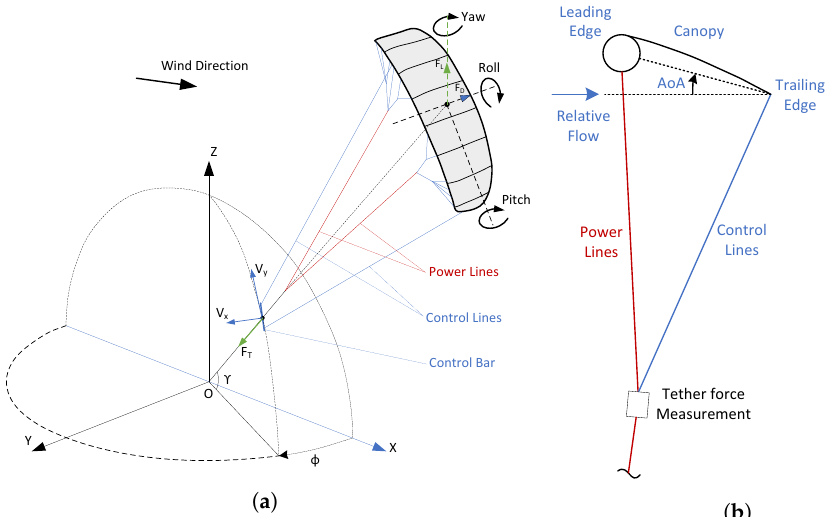
Figure 2. Kite’s position and orientation represented in the spherical coordinate system and the forces experienced by the kite [26]. ( a ) Kite’s orientation and position. ( b ) Angle of attack of the